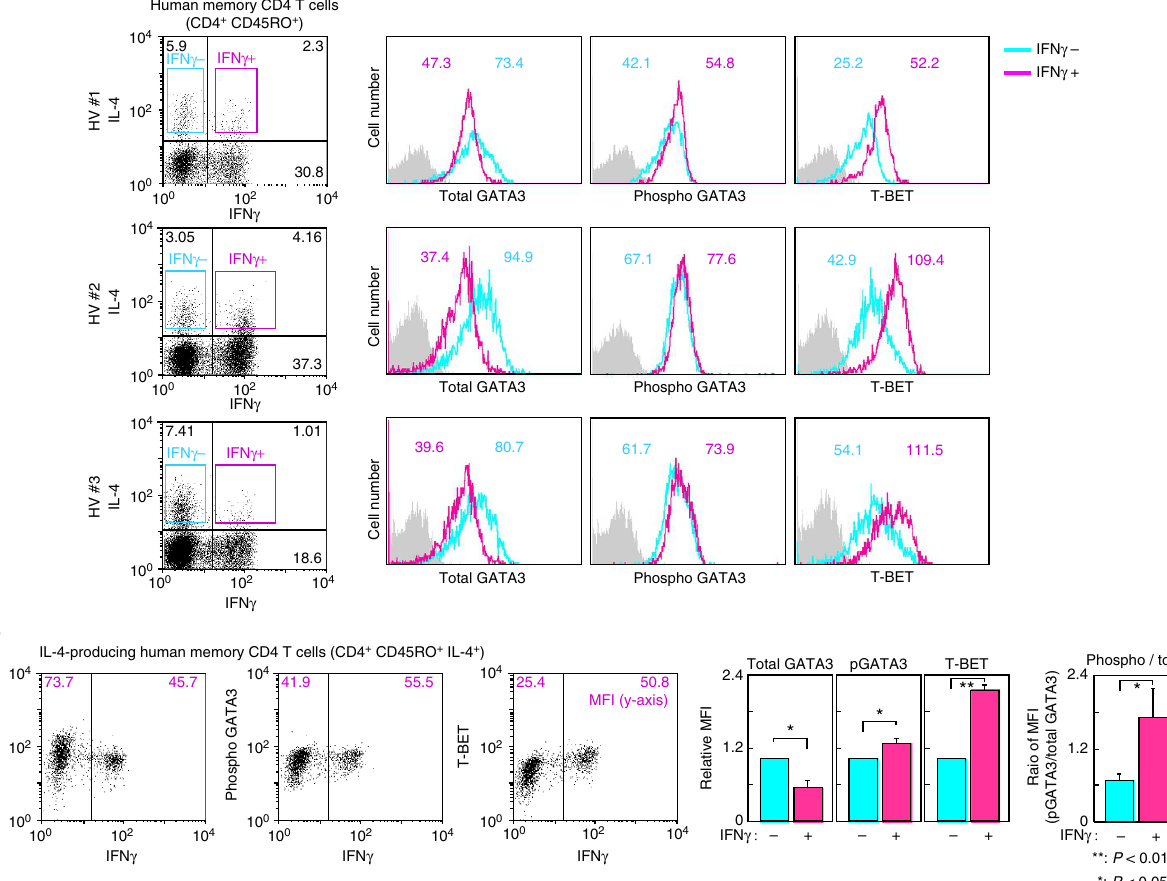
Figure 7 | GATA3 phosphorylation in human IL-4 and IFN c -double-producing memory-type CD4 T cells. ( a ) Human CD45RO þ memory CD4 T cells from peripheral blood were purified and stimulated in vitro for 4h. Intracellular staining profiles of GATA3, phosopho-GATA3 and T-BET in IL-4 þ /IFN g (cid:2) (IFN g (cid:2) ) or IL-4 þ /IFN g þ (IFN g þ ) memory CD4 Tcells are shown. Representative IFN g /IL-4 profiles are shown with percentages of cells in each quadrant (left). The number in the histogram represents the MFI. The grey-filled histogram shows isotype control staining. Experiments using three healthy donor volunteers (HV#1–3) are shown. ( b ) Human CD45RO þ memory CD4 T cells were stimulated and the intracellular staining profiles of IFN g , GATA3, phospho-GATA3 and T-BETare shown with the MFI of the y axis in each area (left). A summary of the MFI of GATA3, phospho-GATA3 and T-BETand the ratio of the MFI (phospho-GATA3/total GATA3) in IFN g -producing and IFN g -nonproducing memory Th2 cells is presented (right) ( n ¼ 3). ** P o 0.01, * P o 0.05 by Student’s t -test. Experiments using three healthy donor volunteers were performed with similar